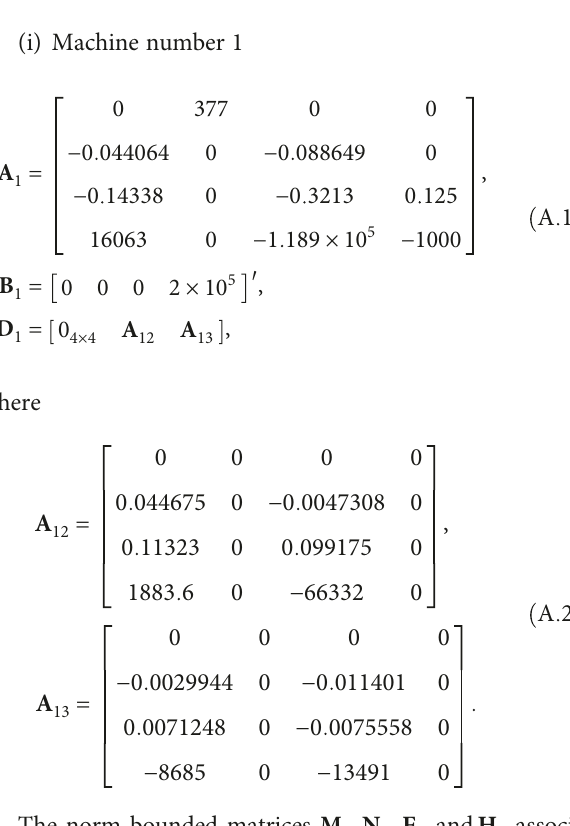
∞ control: (a) rotor angle and (b) control